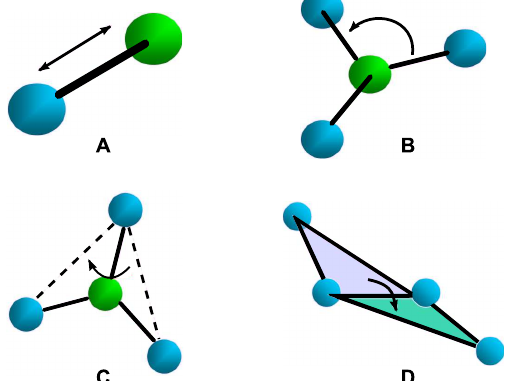
Figure 2. A schematic representation of covalent bondings, ( A ) bond-stretching; ( B ) angle-bending; ( C ) proper torsion; and ( D ) improper